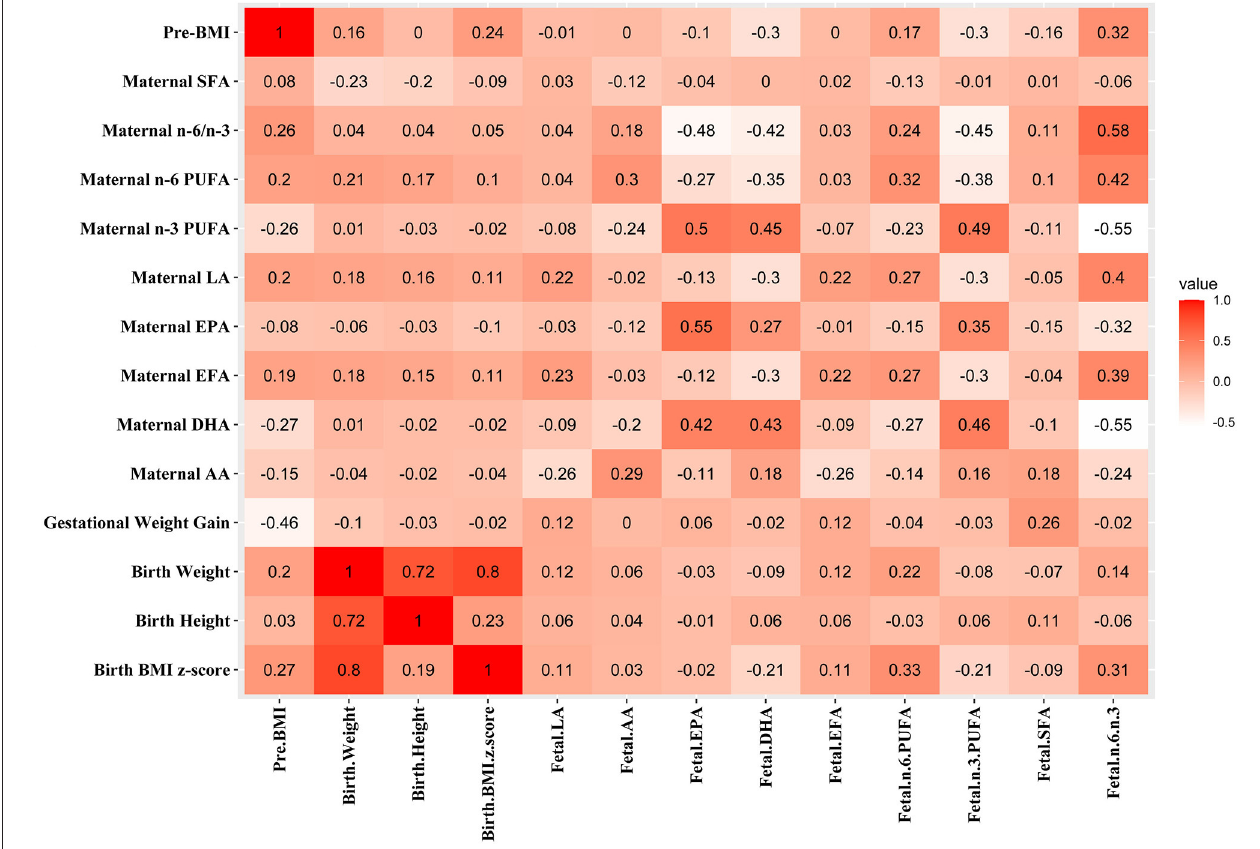
Frontiers in Nutrition |